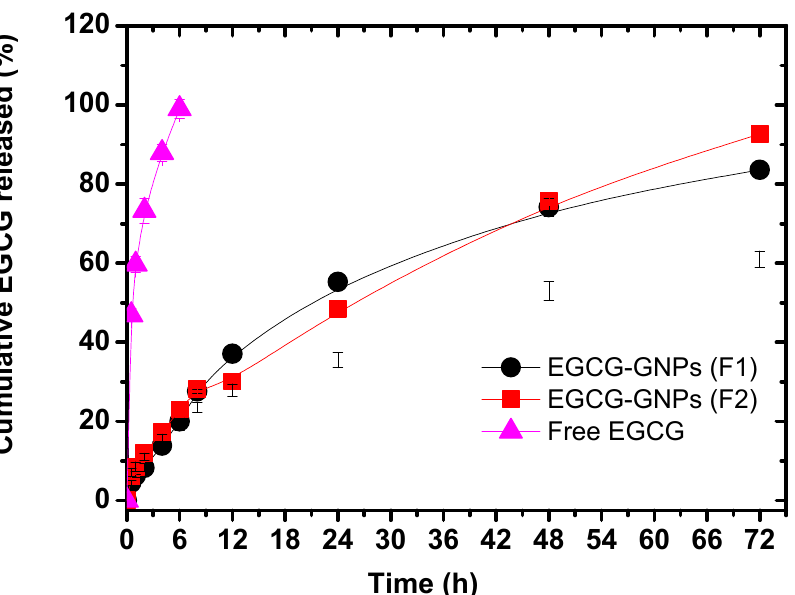
Figure 5. In vitro EGCG release profiles from various GNPs preparations in phosphate buffer pH 7.4 at 37 °C. Loading of EGCG onto GNPs surface significantly slowed down its release rate compared with the drug alone.